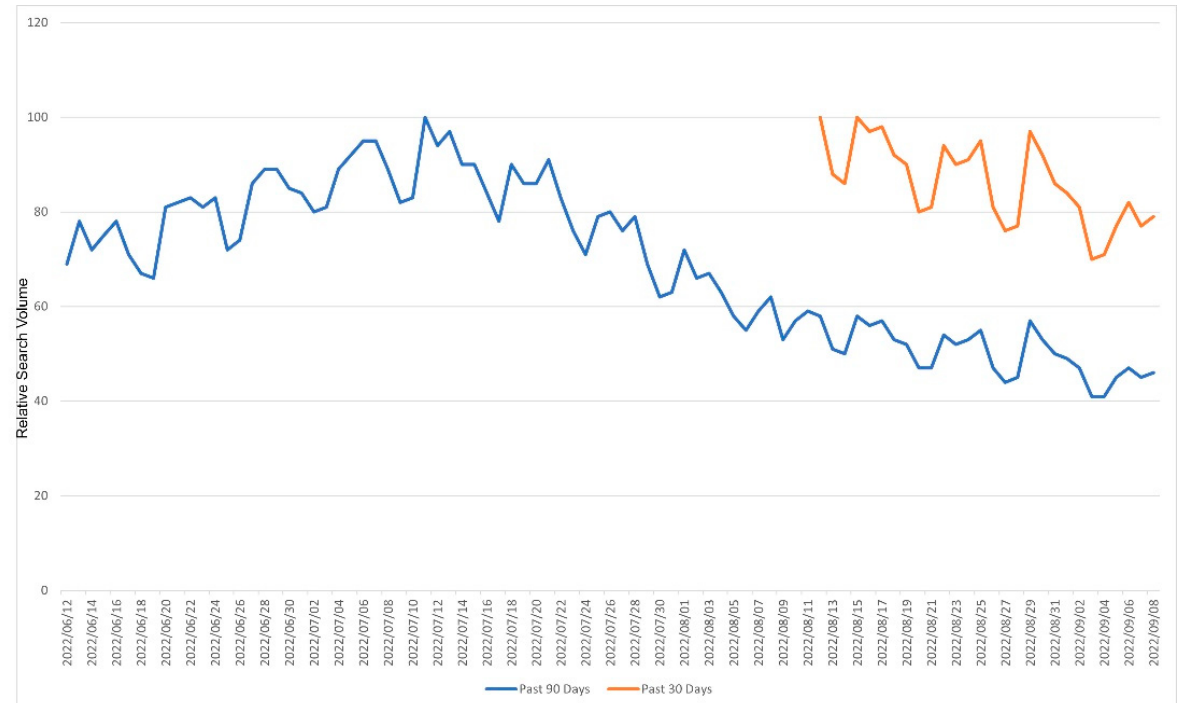
Figure 1. Google Trends results for ‘Coronavirus disease 2019 ′ , retrieved on 12 September 2022 from the Google Trends platform (https://trends.google.com/) based on Worldwide web searches. The data retrieval period was set to the ‘past 90 days’ (blue line) and the ‘past 30 days’ (orange line). Table 1. List of countries included in the comparison of pre- and post-implemented changes to the Google Health Trends API.